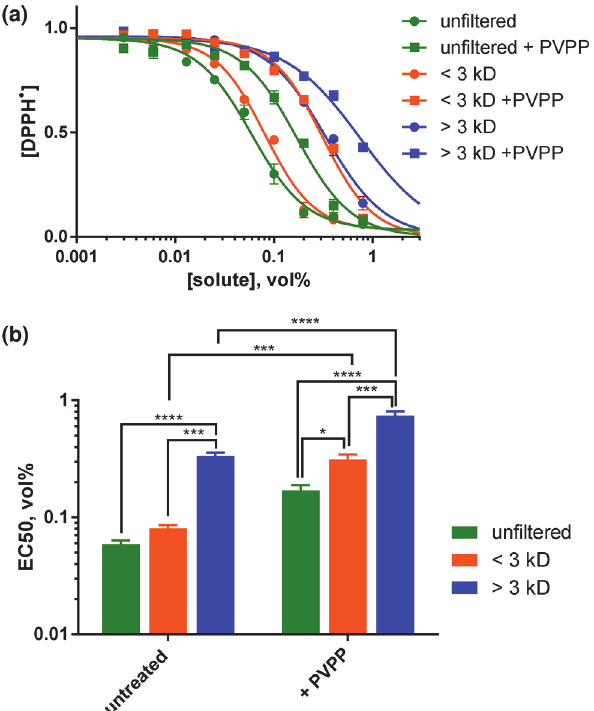
Fig 5. Reduction of DPPH (cid:129) to its hydrazine form DPPH-H in the presence of brewed coffee. (a) Dose response curves; (b) EC50 values calculated from the curves. The brew was optionally pre-treated with PVPP, followed by filtration through a 3 kD MWCO membrane. Reactions contained MeOH/water (1:1) solutions of 50 μ M DPPH and varying dilutions of coffee brew. Significant differences were calculated by two- way ANOVA using the Holm- Š ídák multiple comparison test ( n = 3): **** P < 0.0001, *** P < 0.001, ** P < 0.01, * P < 0.05. Numerical EC50 data is provided in S1 Table.